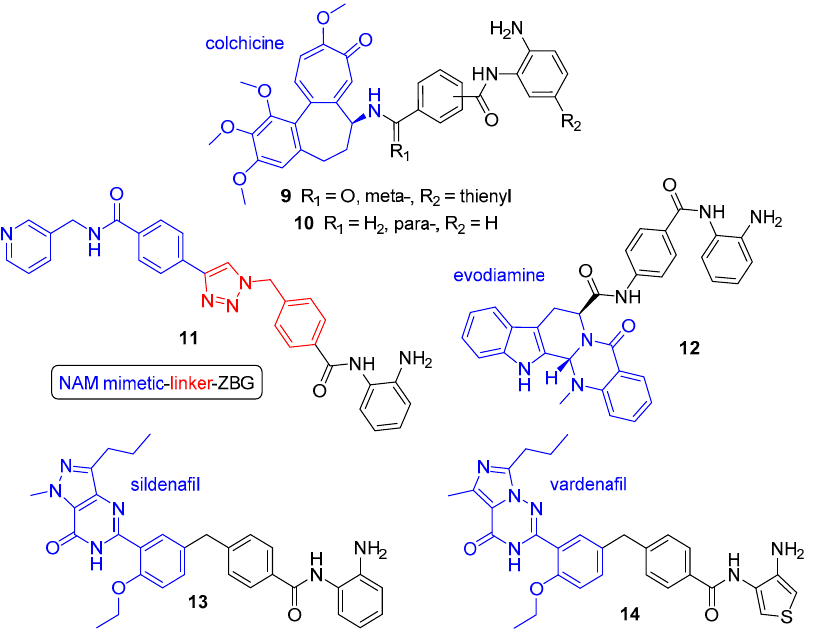
Figure 5. Non-kinase-targeting class-I-selective dual HDAC inhibitors. Components: HDAC inhibitor (black) and moiety for inhibition of second protein target (blue).